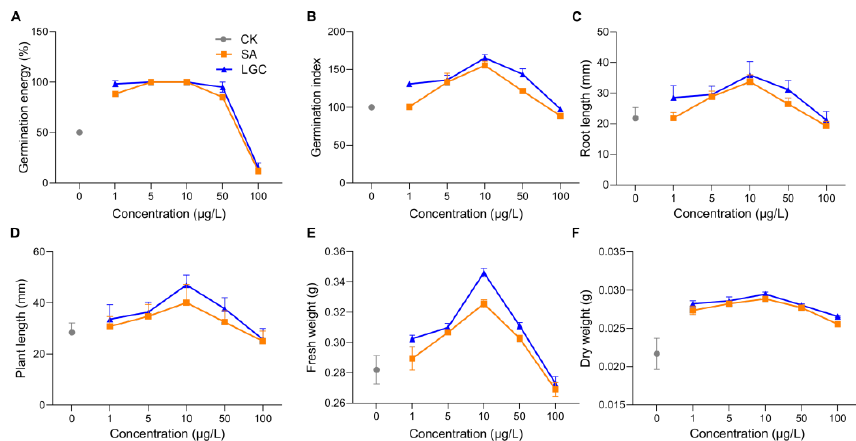
Figure 2. LGC and SA on germination energy ( A ), germination index ( B ) as well as seedling root length ( C ), plant length ( D ), fresh weight ( E ), and dry weight ( F ). Data are mean ± SD. A, B, E, F, n = 3; C, D, n = 60.